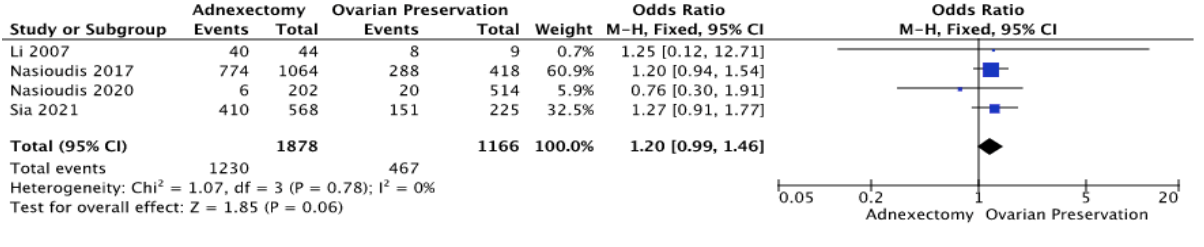
Figure 2. Overall Survival Forrest Plot.